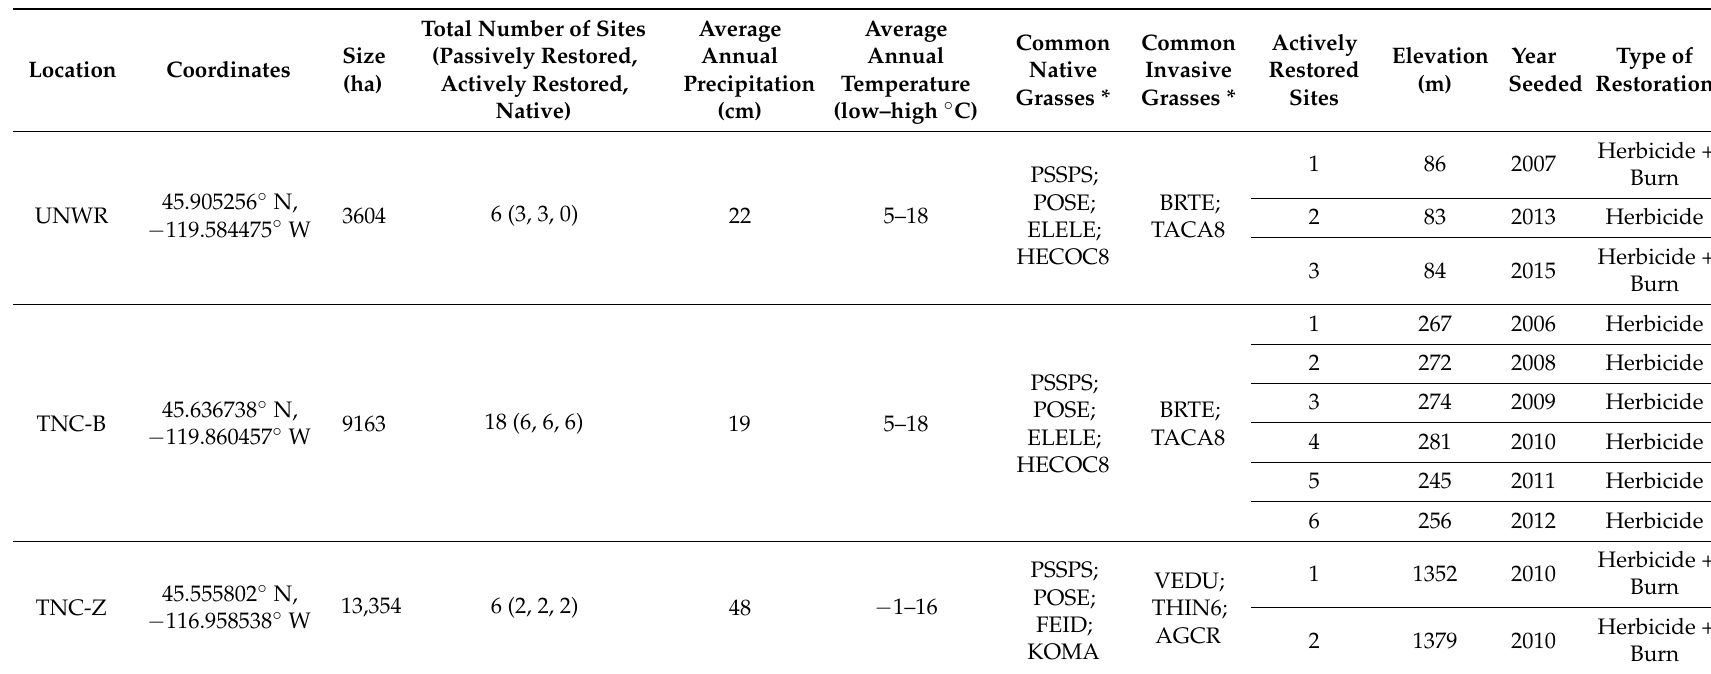
Table 1. Information on restoration sites from the Umatilla National Wildlife Refuge (UNWR) and The Nature Conservancy Boardman Grasslands Preserve (TNC-B) in Morrow County and The Nature Conservancy Zumwalt Prairie (TNC-Z) in Wallowa County, Oregon, including coordinates, size (ha), total number of sites, average annual precipitation (cm) and average annual temperatures ( ◦ C) (30-year averages, US Climate Data, 2017), common native grasses, common invasive grasses, elevation (m), year seeded, and type of restoration. Site refers to an active restoration project at each